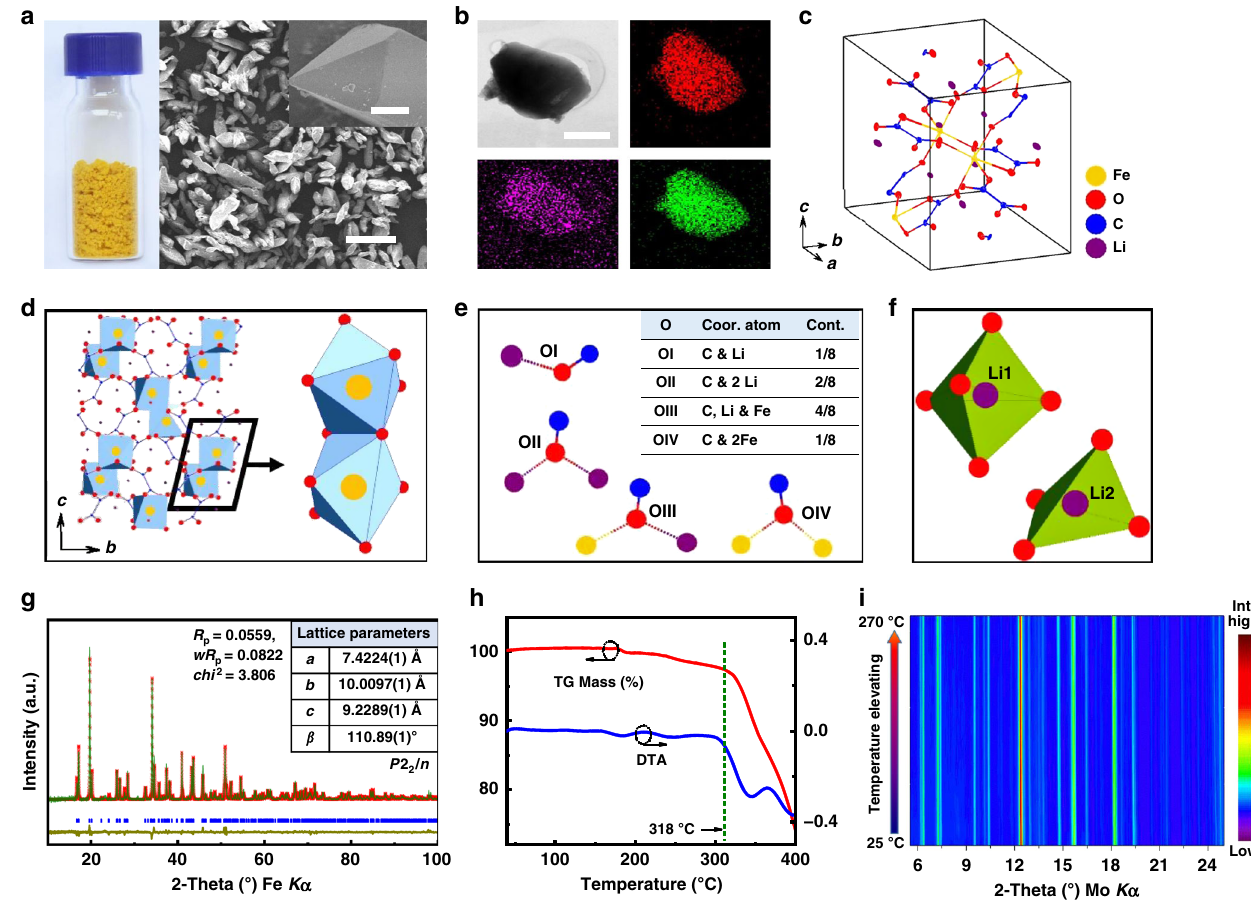
Fig. 1 Characterization of Li 2 Fe(C 2 O 4 ) 2 (LFOx for short). a Photo and SEM image of as-synthesized crystallites (scale bar = 50 μ m). The inset (scale bar